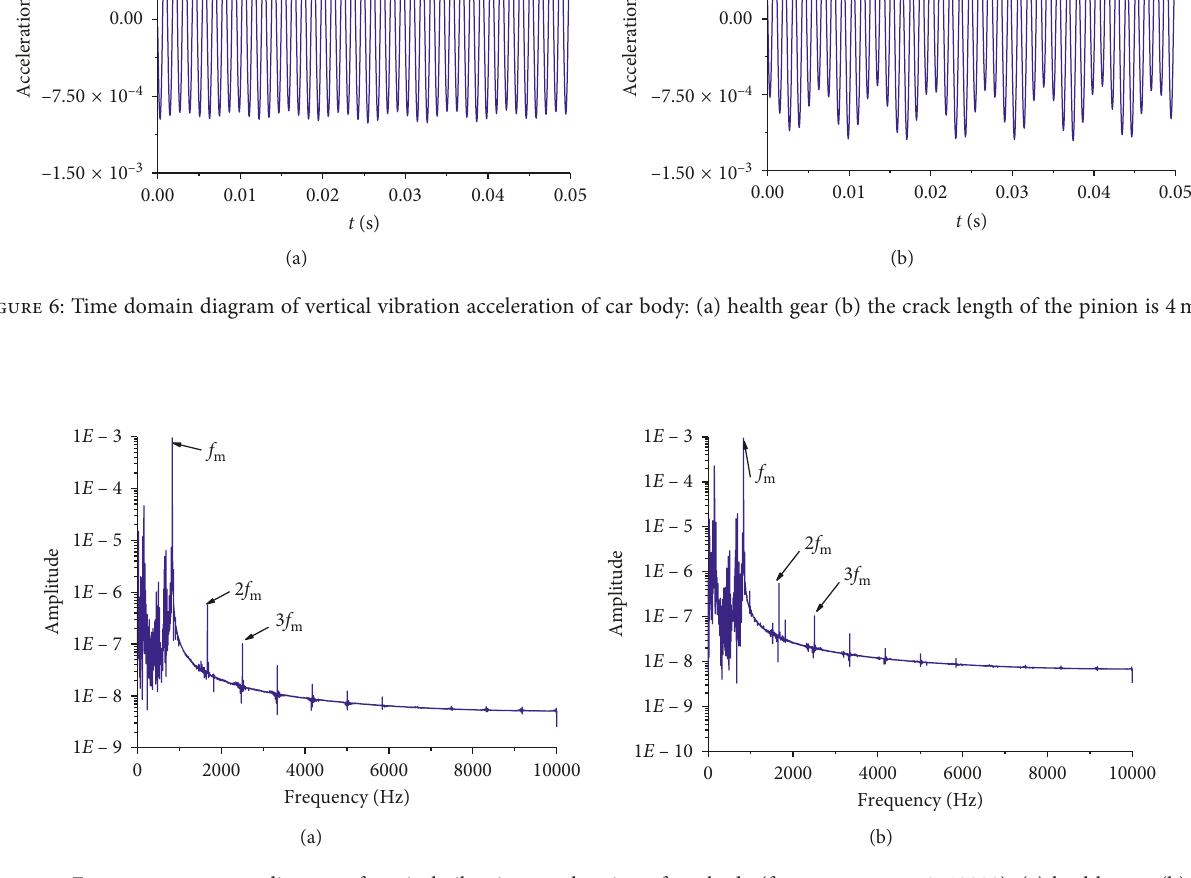
Figure 7: Frequency spectrum diagram of vertical vibration acceleration of car body (frequency range: 0–10000): (a) health gear (b) the crack length of the pinion is 4mm.